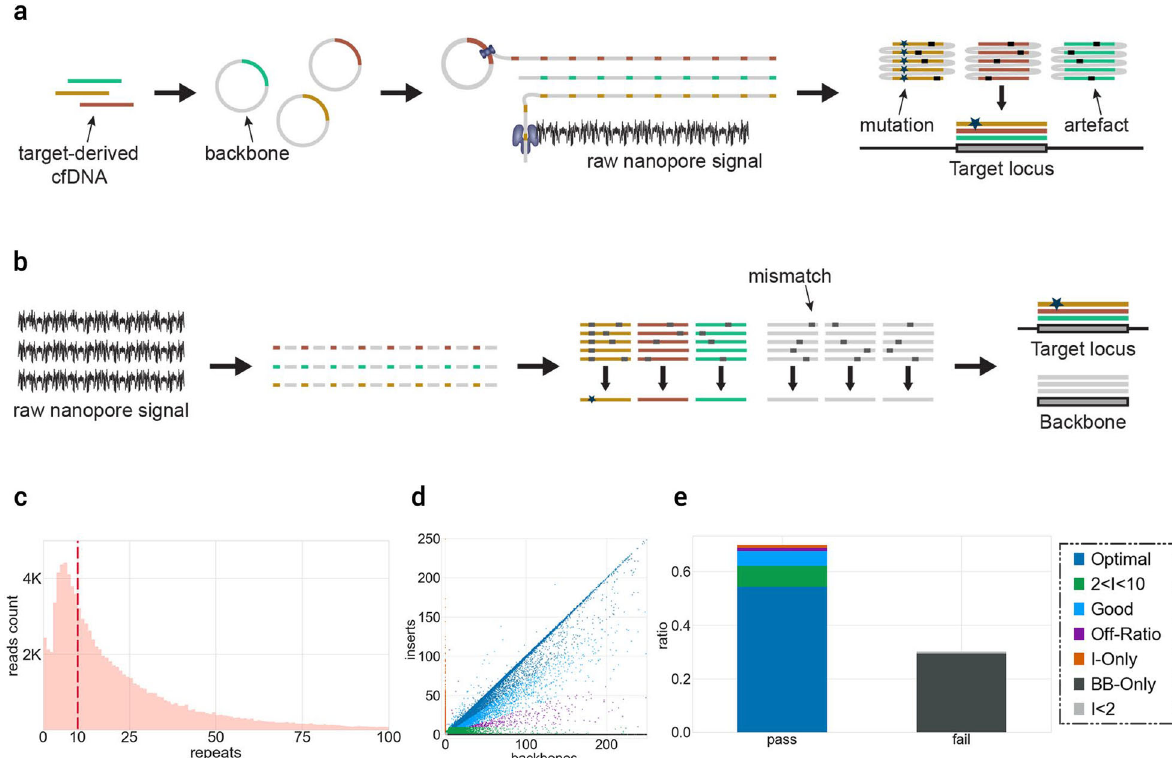
Fig. 1 CyclomicsSeq protocol. a Experimental setup of CyclomicsSeq. PCR-ampli fi ed ( ‘ target-derived') cfDNA is circularized with an optimized DNA backbone. Rolling circle ampli fi cation generates a long DNA molecule with alternating insert and backbone sequences, which is sequenced using ONT sequencing. Consensus calling of the DNA sequence allows discrimination between mutations and sequencing artifacts. b Schematic overview of the bioinformatic pipeline. c Distribution of insert copies versus the number of reads for a